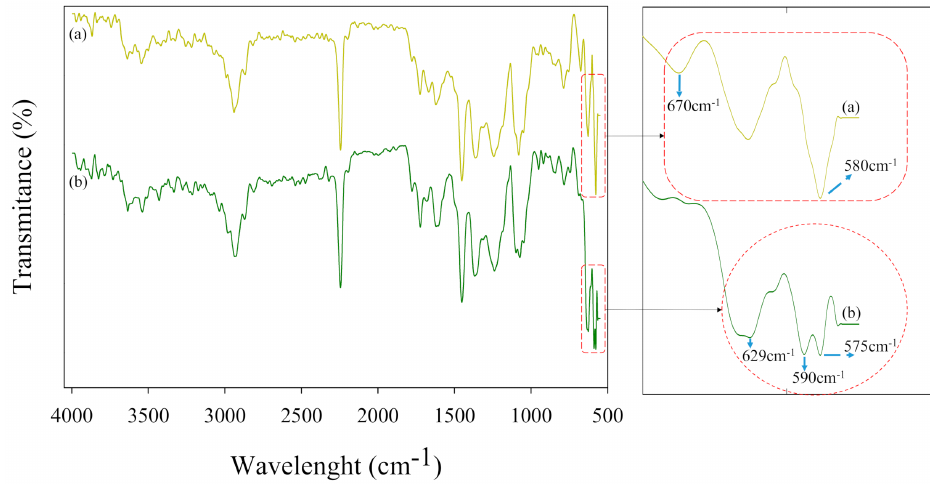
Figure 9. FTIR spectra of composite nanofiber membranes after adsorption: ( a ) PEI-AN, and ( b )